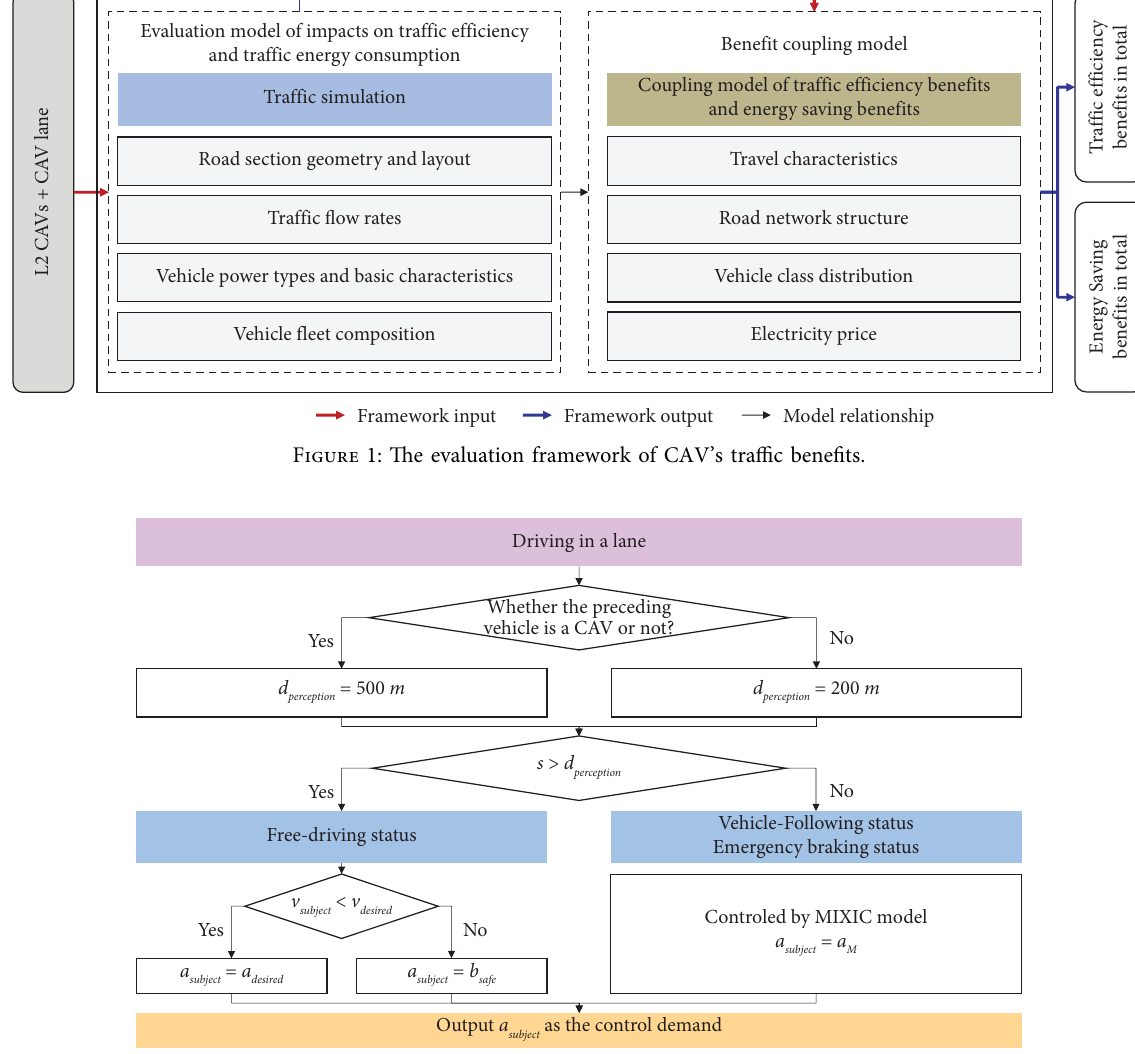
Figure 2: Te longitudinal control strategy of CAVs or